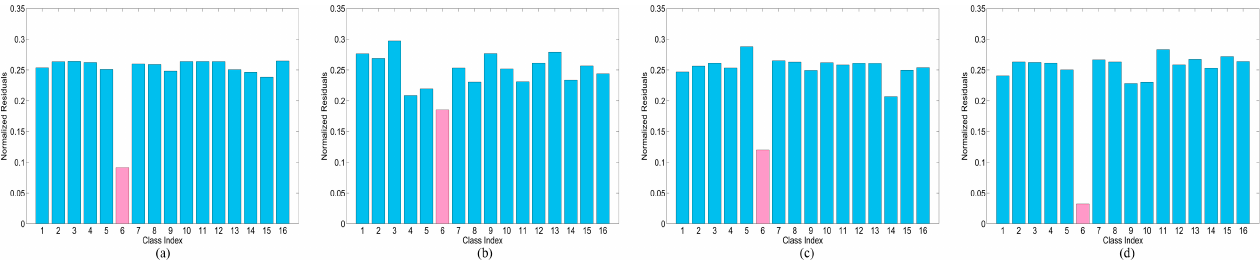
Figure 14. Classification accuracy versus the number of training samples per class. ( a ) Indian Pines. ( b ) Pavia University. ( c ). Salinas. 5.3. Computing Time In order to evaluate the computational complexity of the various classification algo ‐ rithms, all experiments are implemented using MATLAB on a 2.60 GHz CPU workstation with 16 GB of RAM. More detailed information is summarized and then listed in Table 12. As illustrated in Table 12, CRT and MF ‐ SRC are the two fastest algorithms among all these classifiers, with running time less than ten seconds. In comparison, the running time of our proposed algorithms is much slower due to the iterative process involved in the optimization algorithms. Specifically, for the proposed MFCARC and MFCART methods, the dominant computational cost comes from the learning of representation coefficients via the correlation regularization problem in multiple ‐ feature ‐ based subspace, which is implemented by the Iteratively Reweighted Least Squares (IRLS) method. As shown in Table 12, although MFCART costs more time than MFCARC owing to the integration of the distance ‐ weighted Tikhonov regularization, MFCART achieves higher classification accuracy. On the other hand, both of the proposed algorithms provide better classification performance under the small size samples situations, compared with other state ‐ of ‐ the ‐ art classifiers.